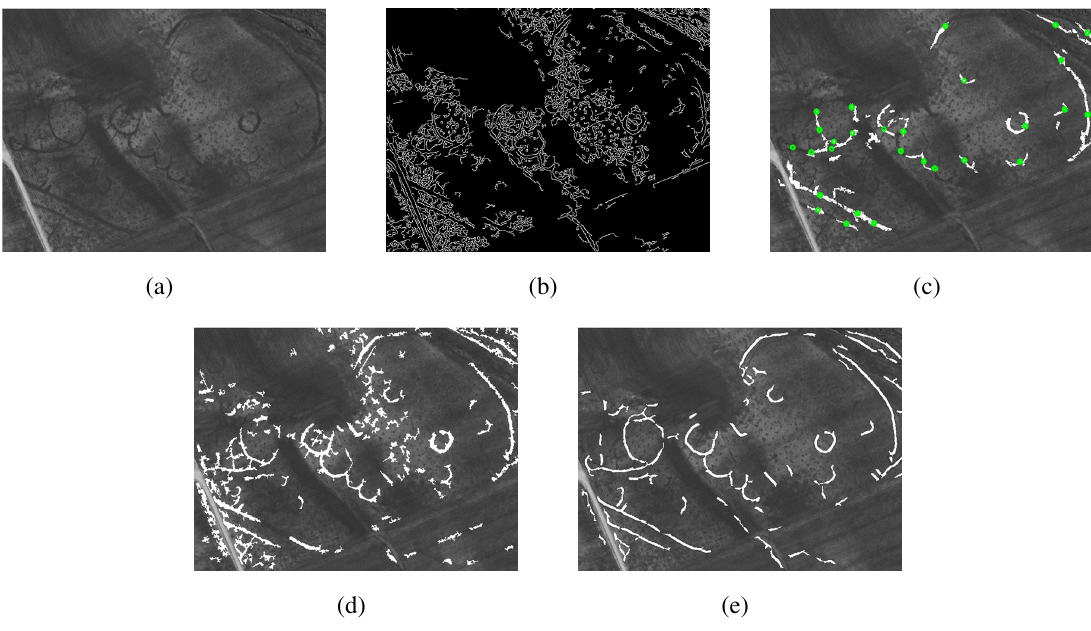
Figure 10. ( a ) A real image of some archaeological crop marks acquired in Apulian Tavoliere ; ( b ) The results of the Canny edge detector; ( c ) Results of the Chan-Vese approach proposed in [37] (the green points represent the manually selected seed points); ( d ) Results of the isotropic nonlinear filtering proposed in [31]; ( e ) Results of the proposed